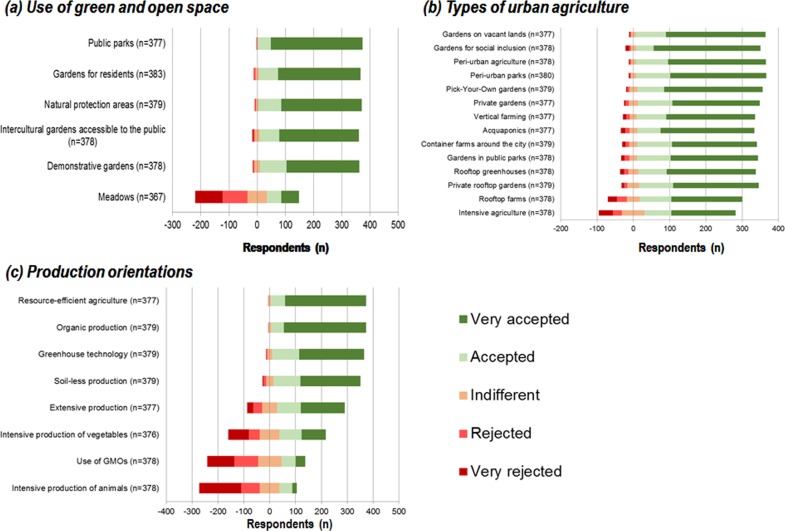
Social acceptance of uses of open and green spaces in the city of Bologna [Q4a], types of UA [Q4b] and production orientations [Q5].